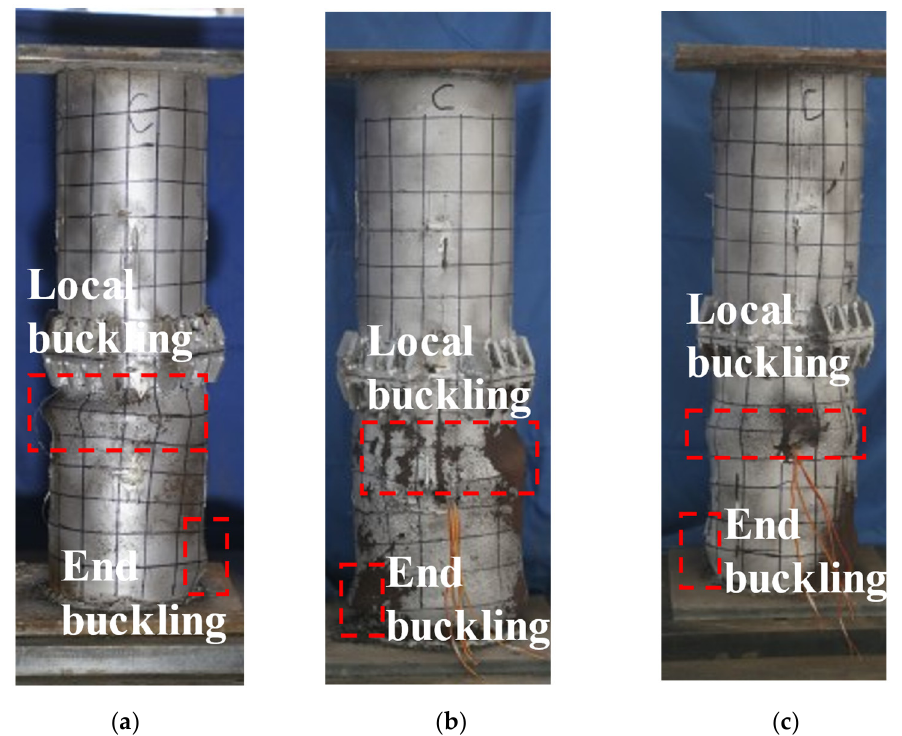
Figure 7. Failure modes of BWCFST short column specimens with spherical-cap gap of different χ : ( a ) χ = 2.3%; ( b ) χ = 4.6%; ( c ) χ =